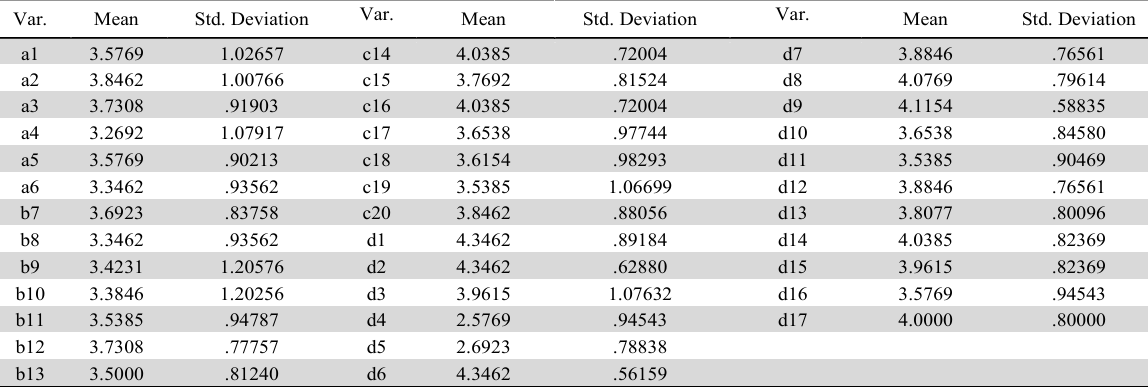
The summary of some basic